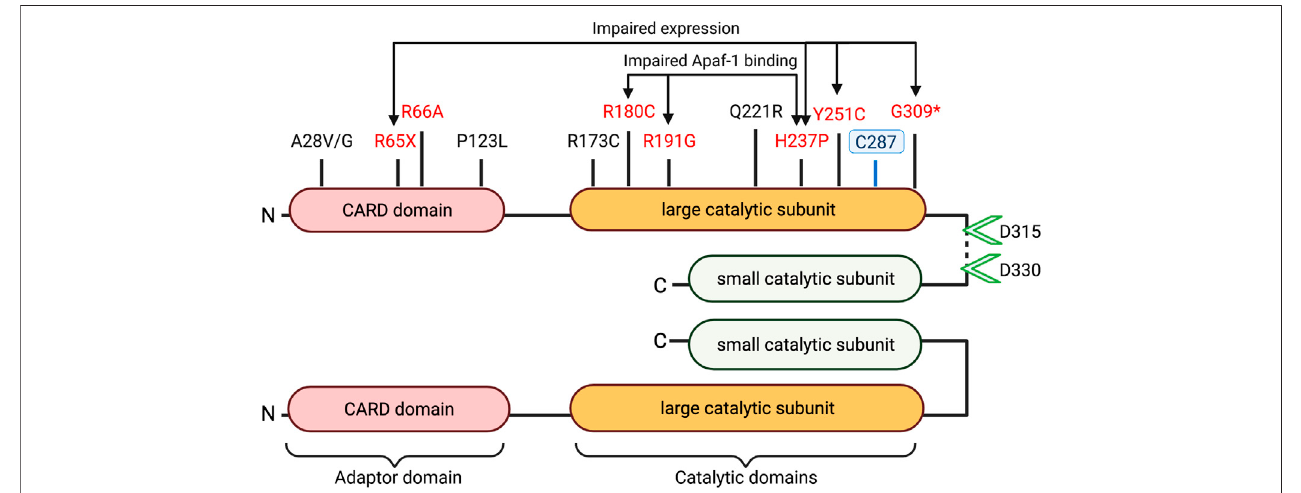
FIGURE 2| Caspase-9 domains and coding sequence variants. Schematic structure of dimerized active caspase-9 domains is depicted with proteolytic cleavage sites (green arrowheads) and catalytic site cysteine at C287 indicated. Disease associated variants marked in black (uncharacterized mutations) or red (loss offunction). (* (cid:1) Frameshift, X (cid:1)